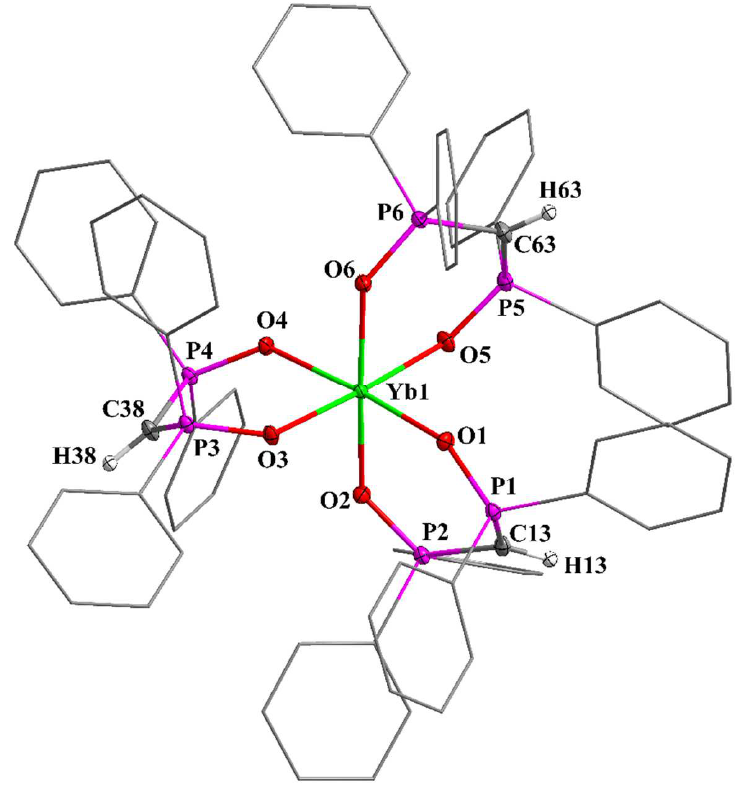
Figure 2. The molecular structure of [Yb(HdppmO 2 ) 3 ) 1 . All hydrogen atoms are omitted for clarity except backbone methanide protons. Lattice acetonitrile is omitted for clarity. Displacement ellipsoids are drawn at the 30% probability level. Selected bond lengths (Å) and bond angles (°) can be found in the ESI, Table S4.